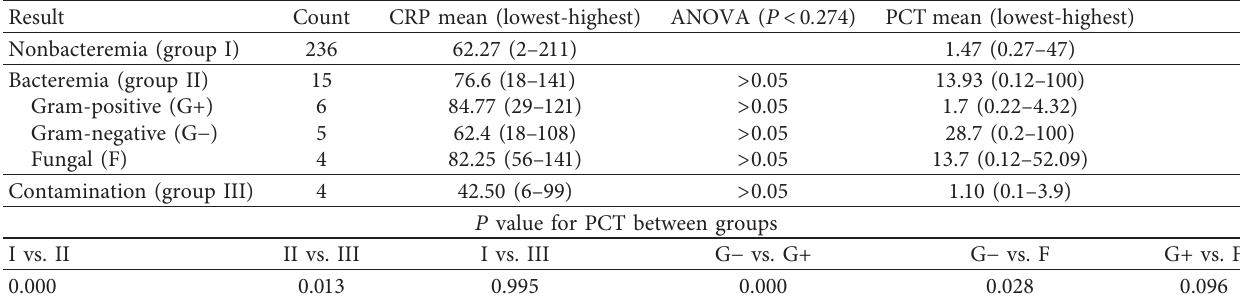
Table 2: The lowest and highest and mean of CRP and PCT concentrations.